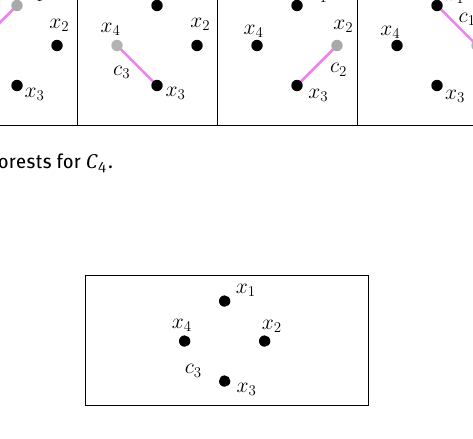
Figure 13: The 4 -rooted forest for C 4